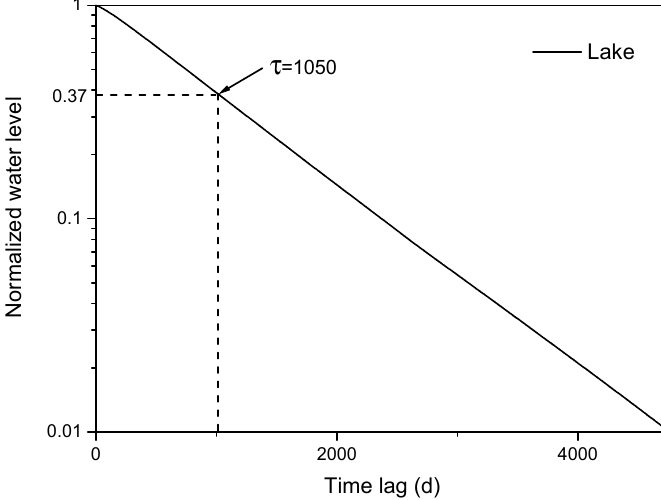
Figure 4. Demonstration of how lake’s response time is estimated based on a normalized time series of water